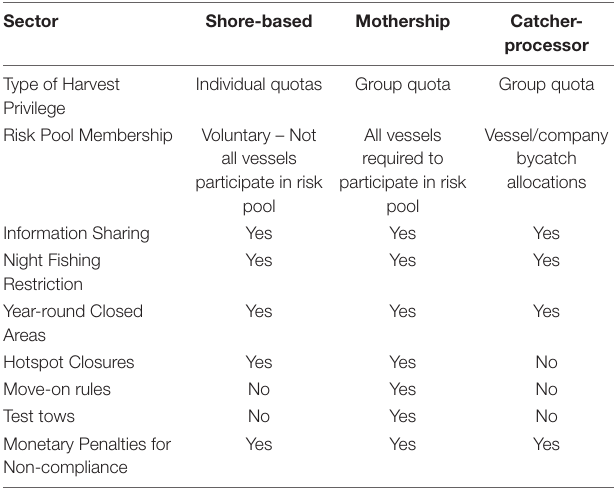
TABLE 1 | Whiting industry and cooperative structure and bycatch avoidance practices.